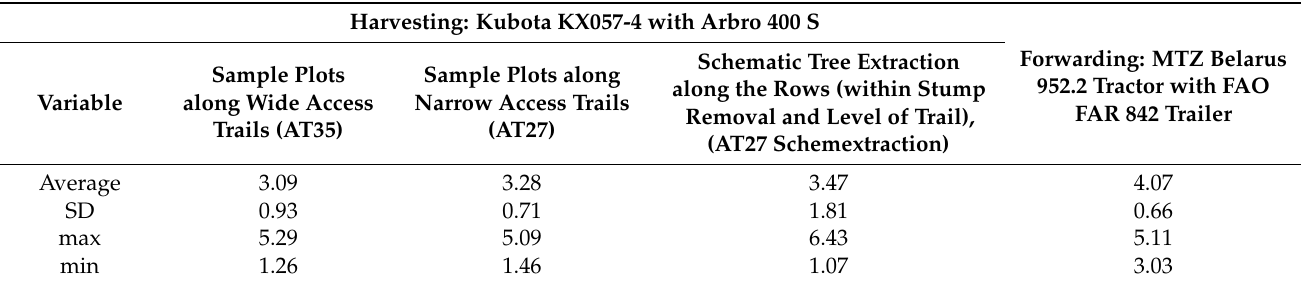
Table 5. Productivity characteristics of sample plots, m 3 /PMH 15 .